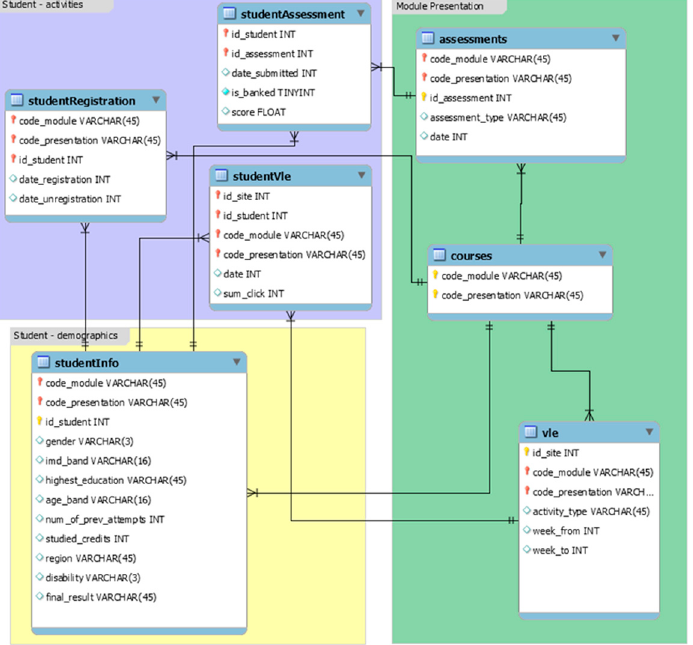
Figure 2. Database schema of OULAD dataset (online available at https://analyse.kmi.open.ac.uk/